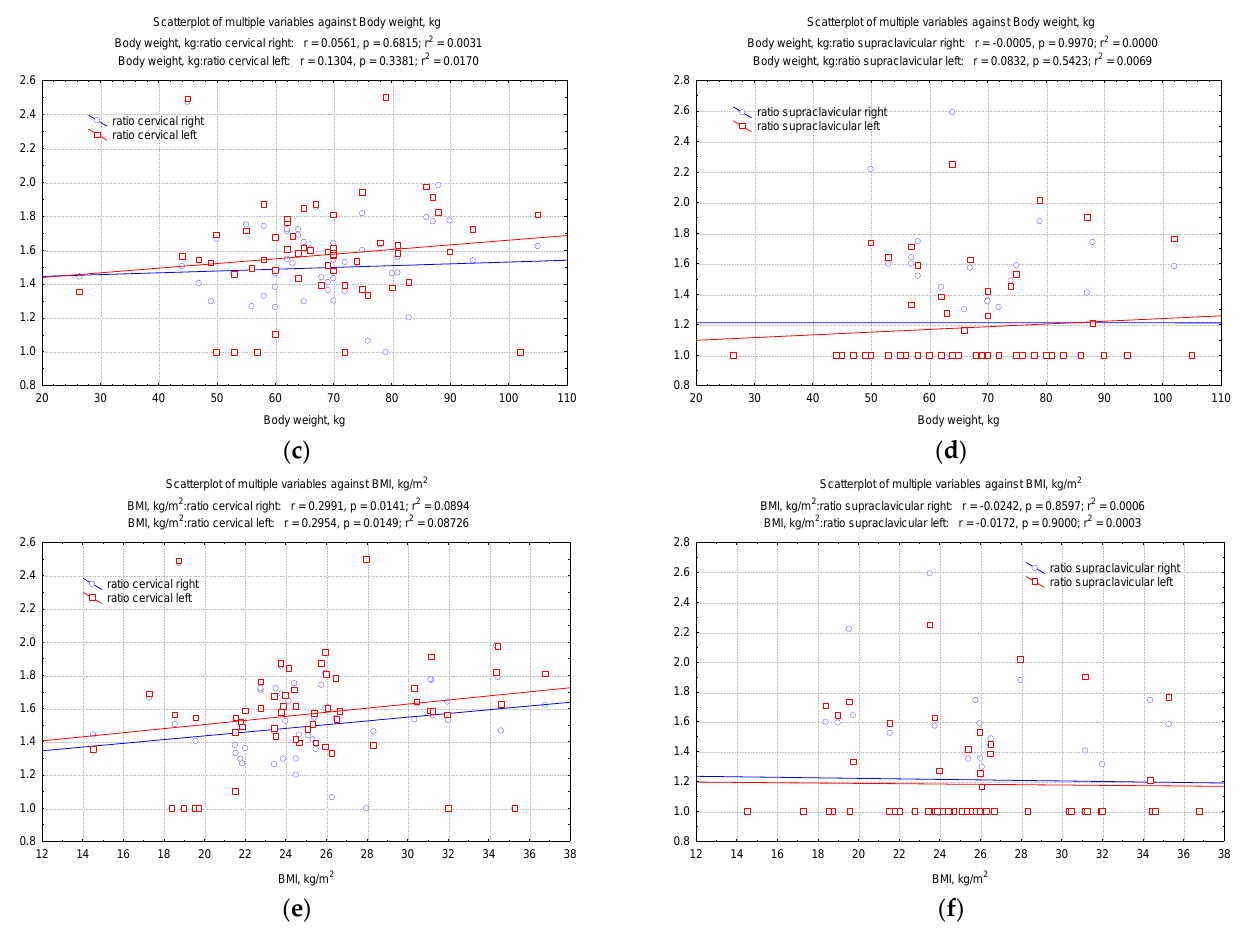
ratio cervical right ratio cervical left